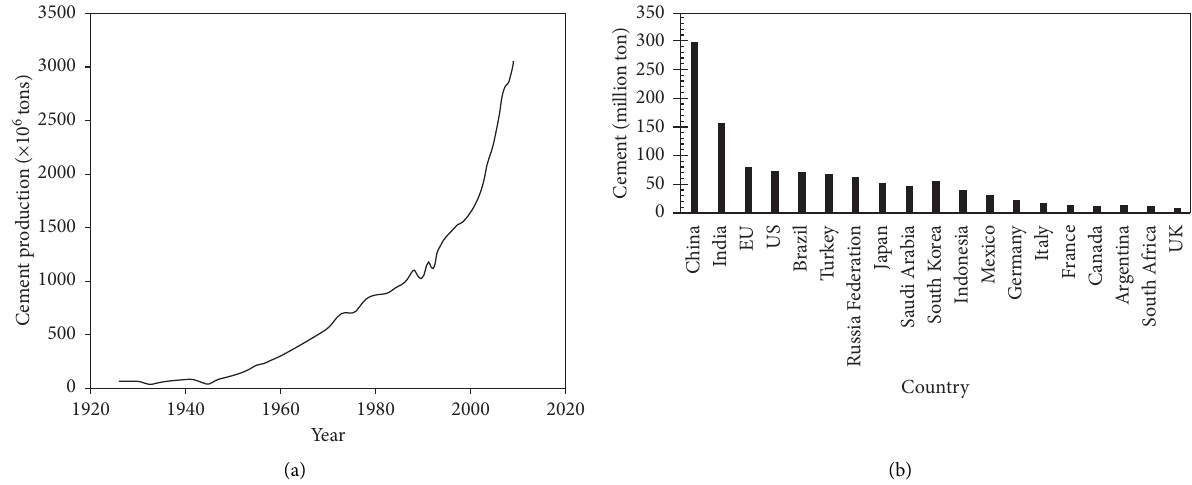
Untreated clayey soil paste (7 days cured) Figure 6: Microstructural comparison of clay soil paste cured at 7 days (untreated sample, treated with 8% lime, treated with 20% pozzolan+8% lime) (modified after